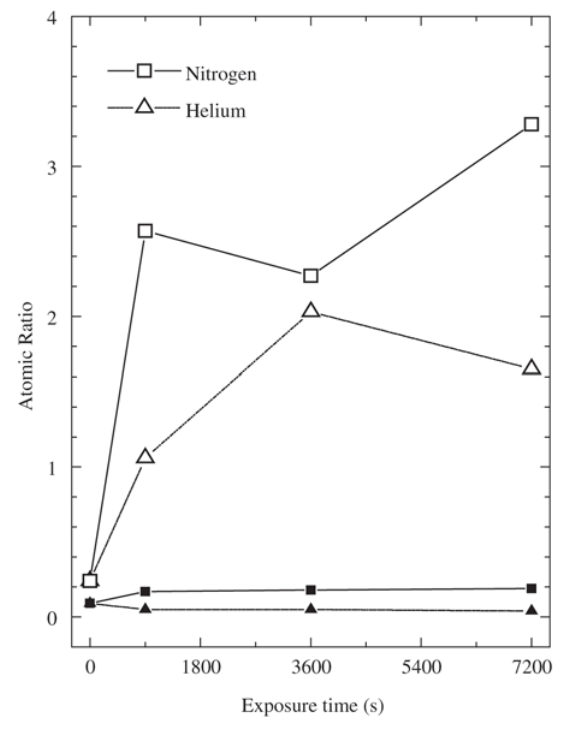
Figure 2. O/C (open symbols) and N/C (solid symbols) atomic ratios as a function of t in nitrogen or helium bombarded